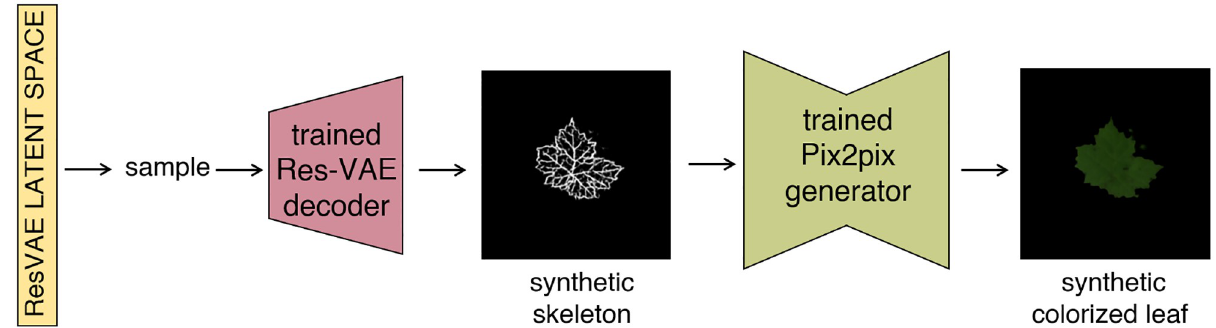
Fig 4. L2L workflow illustration. A random input vector is drawn from the ResVAE latent space representation and is input into the trained ResVAE decoder. This latter outputs a synthetic leaf skeleton, which in turn is fed into the trained generator of the Pix2Pix and translated into a corresponding colorized